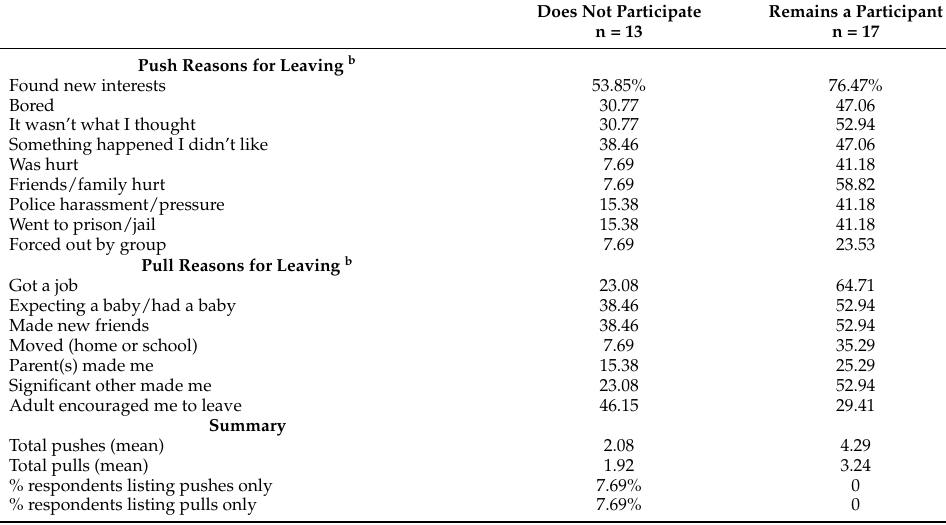
Does Not Participate Remains a Participant n = 13 n =